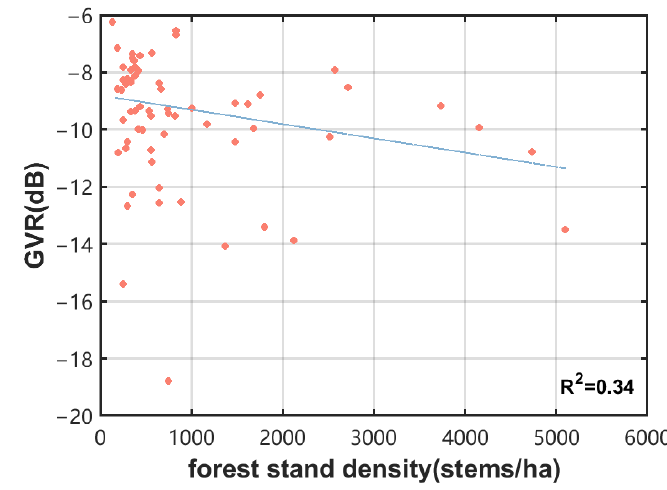
Figure 15. Linear plot of the GVR and stand density.